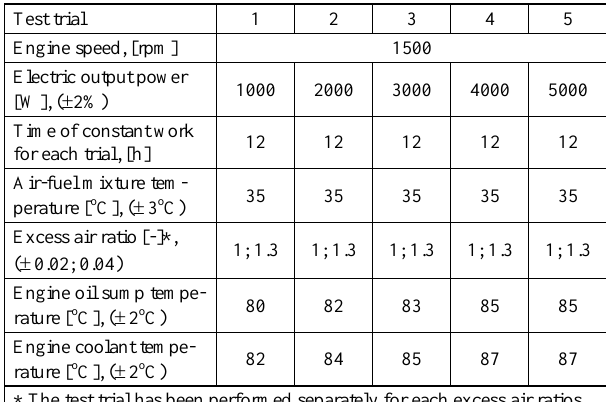
Table 3. CHP system prototype points during the tests and selected system operating parameters